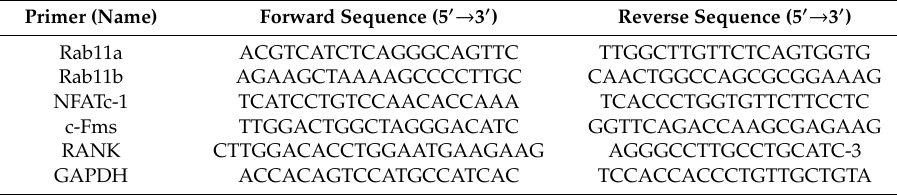
Table 1. List of sequences of DNA primers designed and used for quantitative real-time